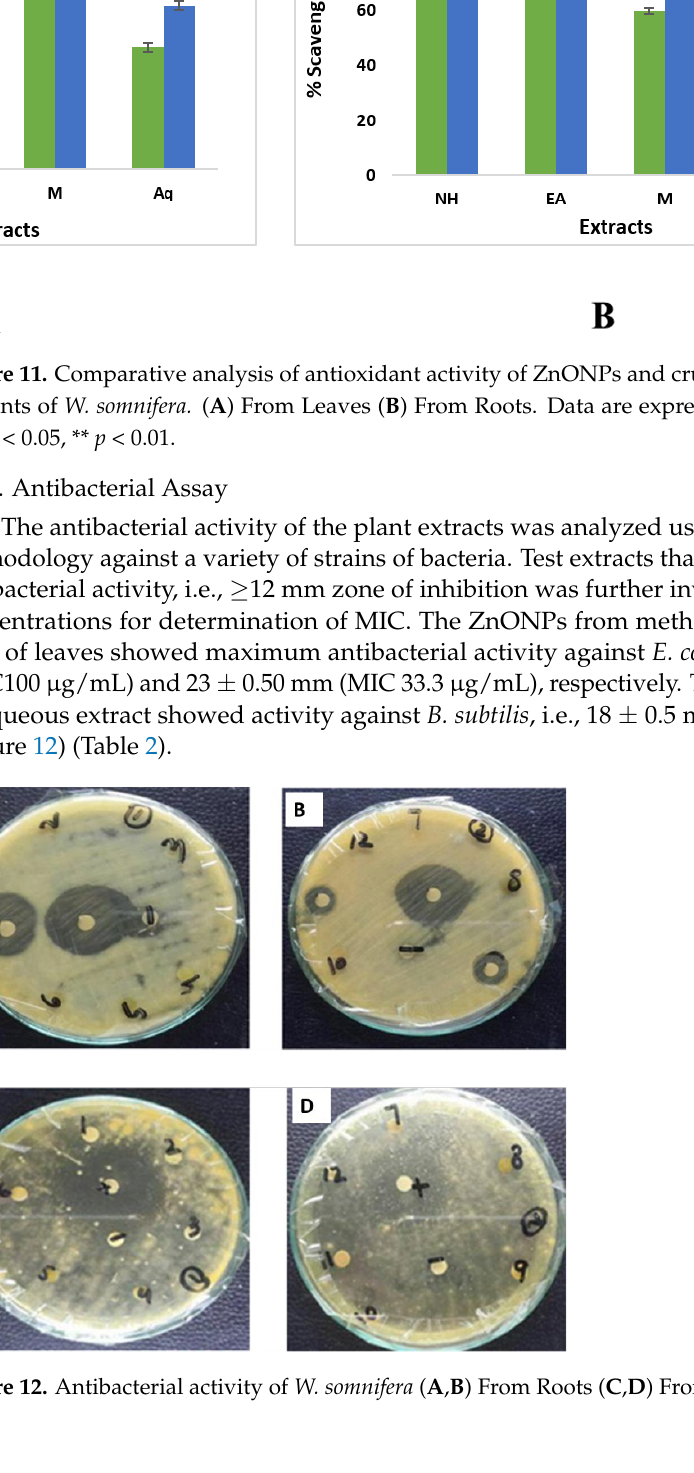
Figure 12. Antibacterial activity of W. somnifera ( A, B ) From Roots ( C, D ) From Leaves. In the case of roots, ZnONPs from EA and aqueous extracts showed significant an- tibacterial activity, i.e., 21 ± 0.70 mm (MIC 33.3 µg/mL) and 18 ± 0.61 mm (MIC 100 µg/mL) against K. pneumonia , respectively. Aqueous extracts also showed antibacterial activity against S. aureus 22 ± 0.51 mm (MIC 33.3 µg/mL) and E. coli 20 ± 0.86 mm (MIC 33.3 µg/mL), respectively (Figure 12) (Table